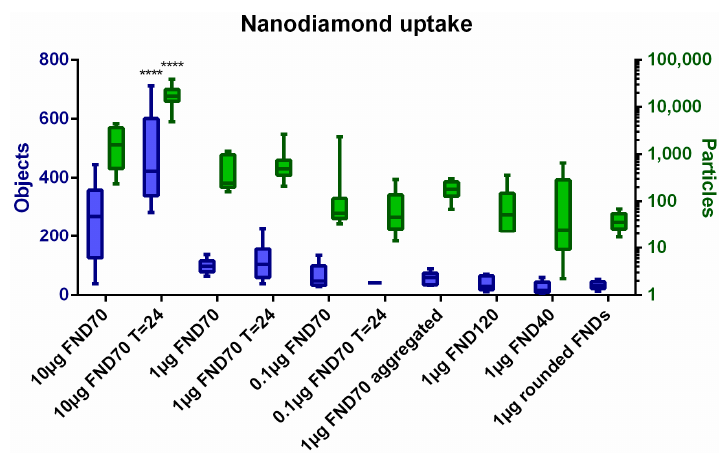
Figure 2. FND uptake in HeLa cells. After confocal imaging, cells are analysed using FIJI software. Our analysis counts the objects and particles inside cells, giving an arbitrary measure for the amount of diamonds taken up. Objects are adjacent FND positive pixels in cells, incorporating both single particles and aggregates or adjacent particles. Particles represent an estimation of the amount of FNDs, calculated by the intensity and size of the objects. The sample incubated with more nanodiamonds, 10 µg of 70 nm FNDs T = 24, resulted in significantly more nanodiamonds per cell ( p < 0.001) in comparison to most other samples with the exception of 10 µg of 70 nm FNDs T = 0.